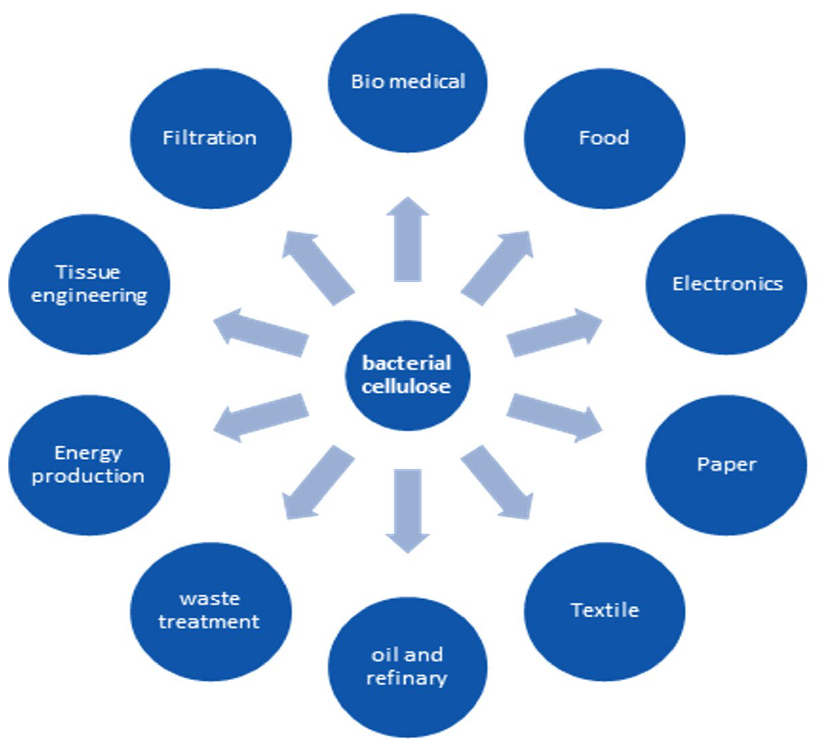
Fig. 1. Applications of bacterial